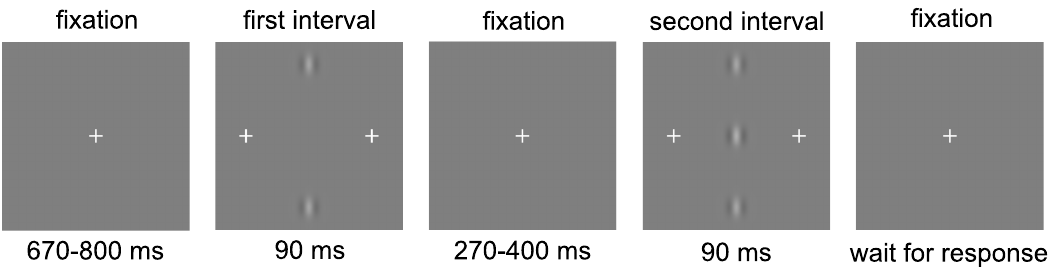
Figure 2. Observers were required to select which of two presentations contained the central Gabor target. In this example, the target is presented in the second